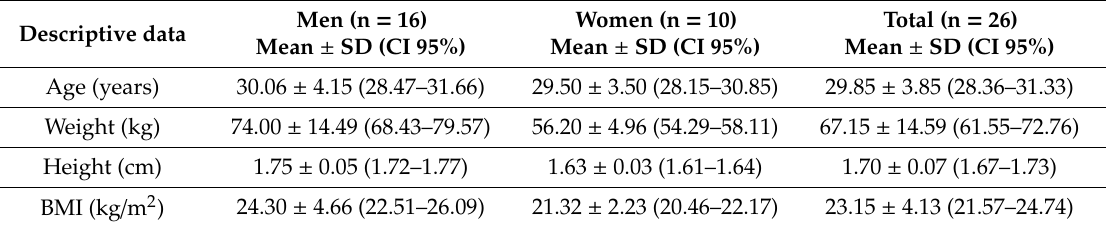
Table 1. Descriptive data of the study